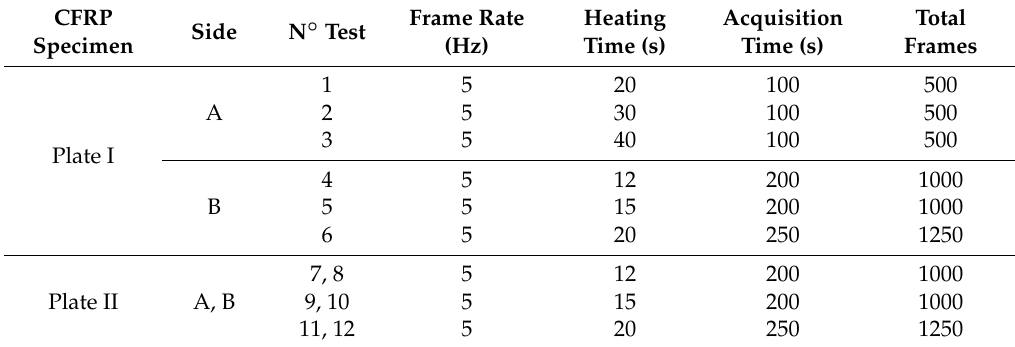
Figure 3. ( a ) Top view of the thermographic setup for CFRP plates’ acquisition and ( b ) experimental setup. Table 4. Scheduling tests for the investigations with different heat pulses